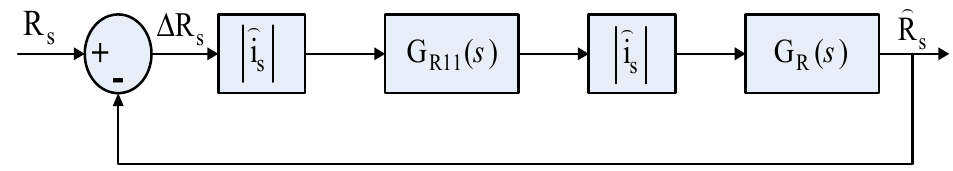
Figure 5. Stator resistance estimation loop.